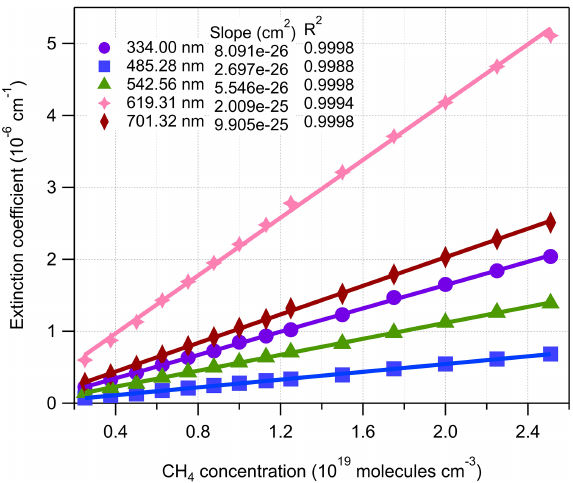
Figure 7. The relationship between BBCES-system-measured ex- tinction coefficients of CH 4 + He mixtures and CH 4 concentration. The selected wavelengths were located in Fig. 6 by vertical lines.